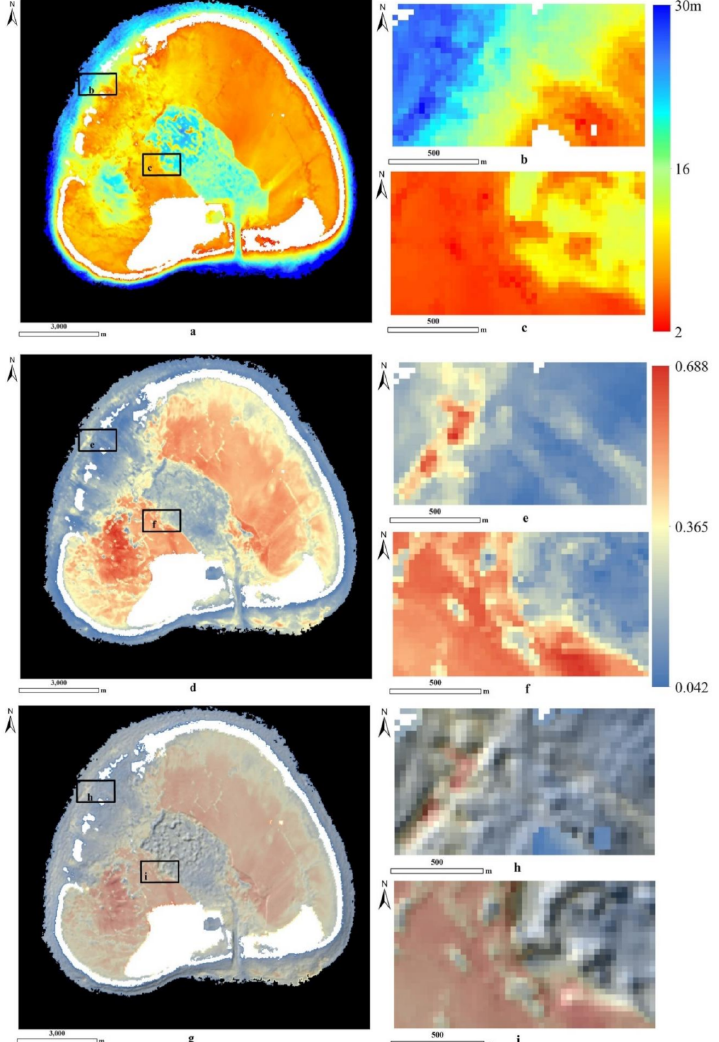
Figure 9. Inversion results of Midway Island using Landsat-8. ( a ) Bathymetry map. ( d ) Bottom reflectance map at 550 nm. ( g ) Superimposed map of ( a , d ). Where ( b , c ), ( e , f ), ( h , i ) are superimposed maps of ( a , d , g ),